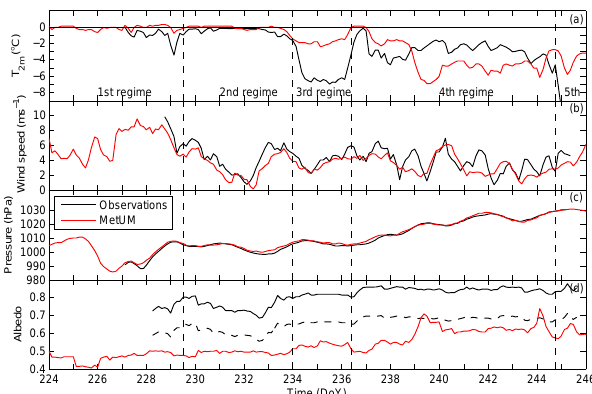
Fig. 2. 3-hourly averaged (a) near-surface air temperature, (b) wind speed, (c) pressure and (d) albedo observations and diagnostics from the MetUM, as a function of time (DoY, day of the year). DoY 226 is 13 August 2008. The dashed line in (d) represents an estimate of the spatially averaged surface albedo. The vertical dashed lines represent the boundaries between the five temperature